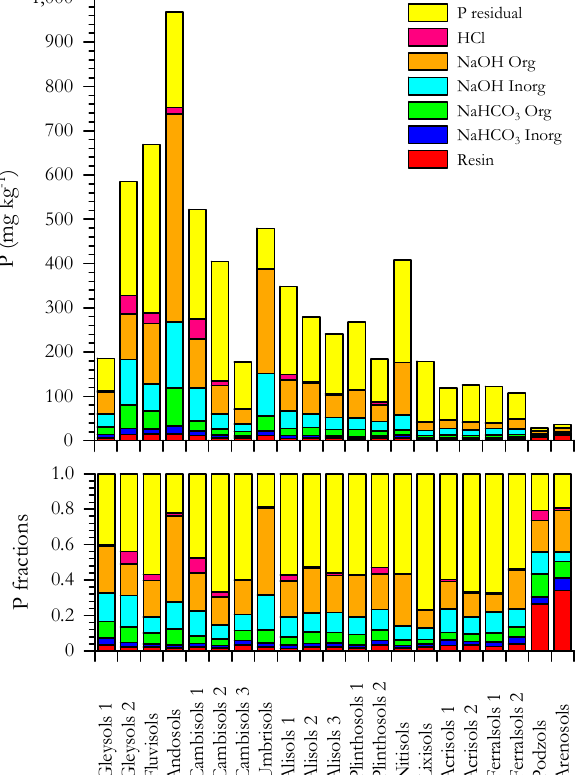
Fig. 7. Average phosphorus concentration in each fraction (top) and as fraction of total P (below) for each RSG and lower classification